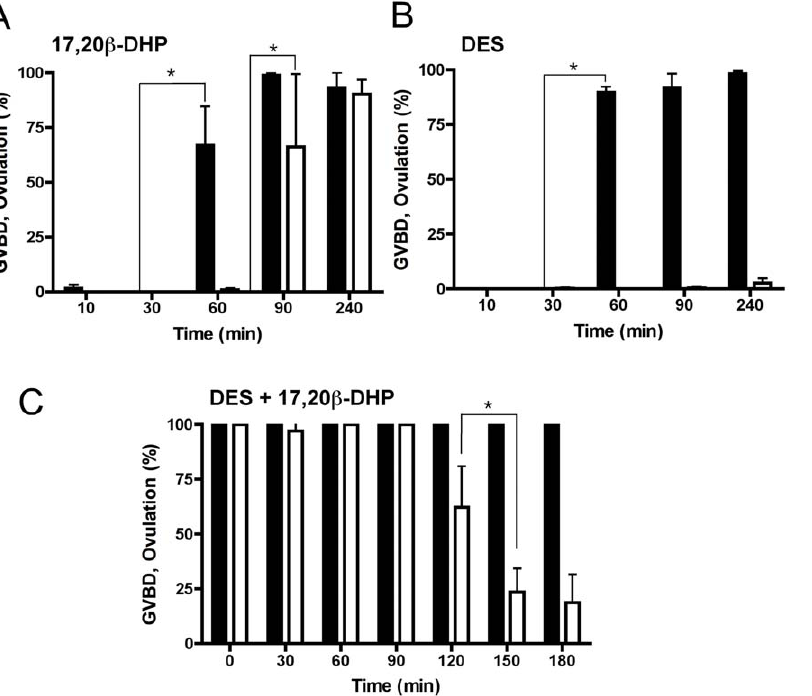
Figure 3. Effect of the length of treatment time of 17,20 b -DHP and DES treatment during induction of oocyte maturation invivo . (A, B) Each agent was added at time zero. Agents were then washed-out by changing the water three times at indicated times. After four hr incubation, %GVBD and %ovulation was assessed by scoring the oocytes. Each panel shows 17,20 b -DHP (A) and DES treatment (B). (C) Effect of serial treatment with DES and 17,20 b -DHP. Incubation was started by the addition of DES. Then, 17,20 b -DHP was added at the indicated times. %GVBD (closed column) and %ovulation (open column) was assessed by scoring the oocytes after four hours from addition of 17,20 b -DHP. Each value represents the mean of data from three different females. Vertical lines indicate standard deviation.